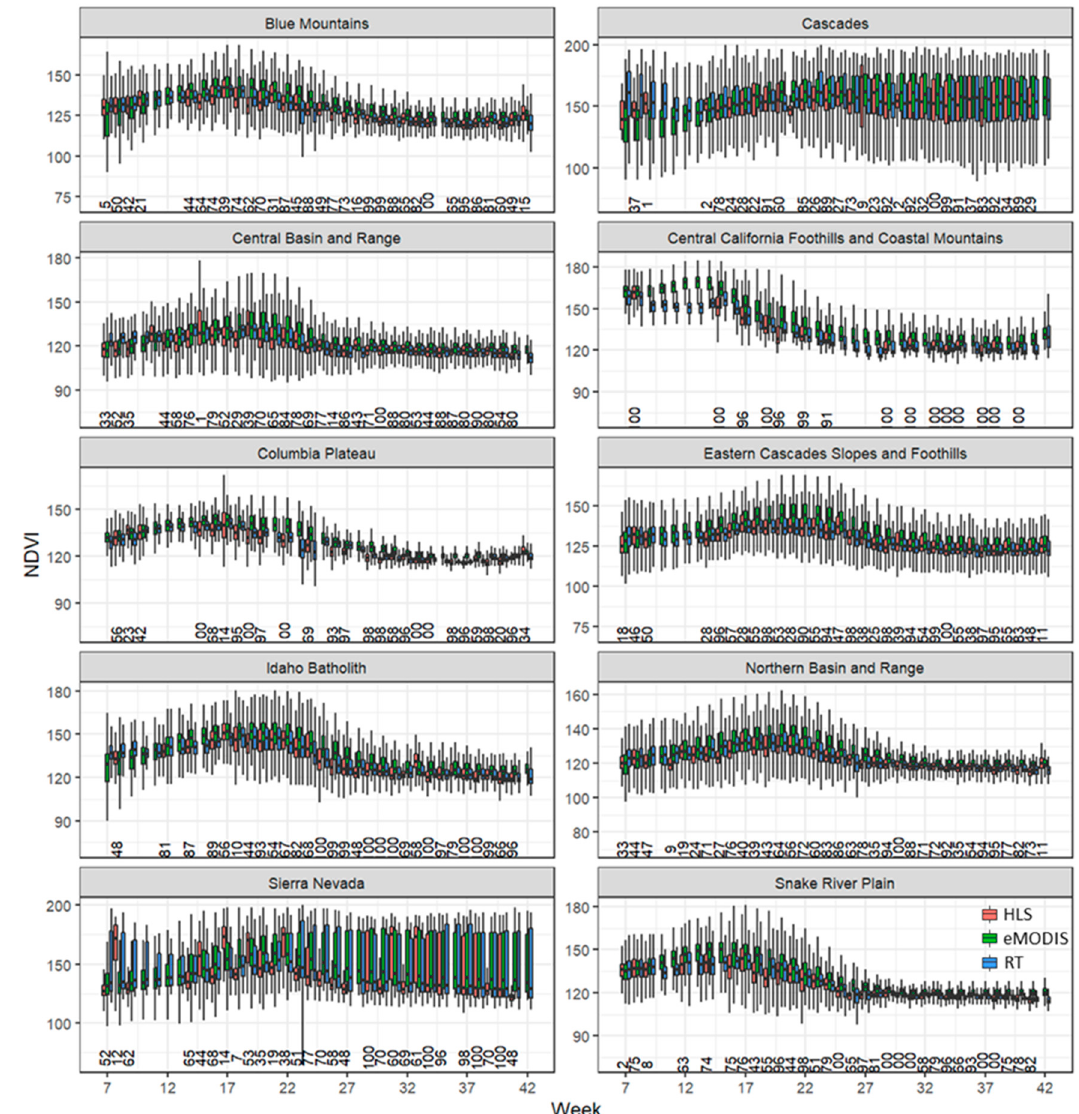
Figure 2 . Time series of Normalized Difference Vegetation Index (NDVI) derived from harmonized Landsat and Sentinel-2 (HLS) data, regression tree models, and expediated Moderate Resolution Image Spectroradiometer (eMODIS) dataset within rangelands stratified by level III ecoregions [28]. The box plots show the interquartile range and median weekly NDVI values (horizontal black line) in 2016. The whiskers extend to a range of values that are within the median ± 1.5 times the interquartile range. HLS data coverage (%) is displayed at the bottom of each panel and rounded to the nearest whole number. NDVI is scaled (100 × + 100) to an 8-bit unsigned integer.